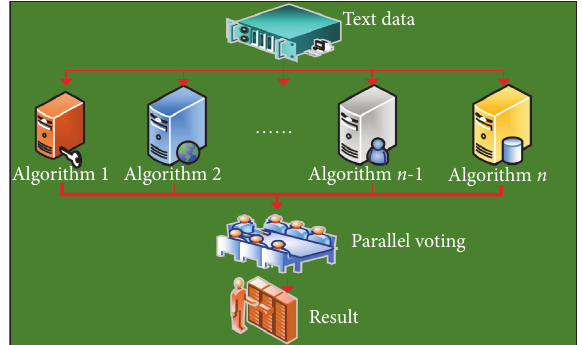
Figure 5: Flow chart of parallel combination